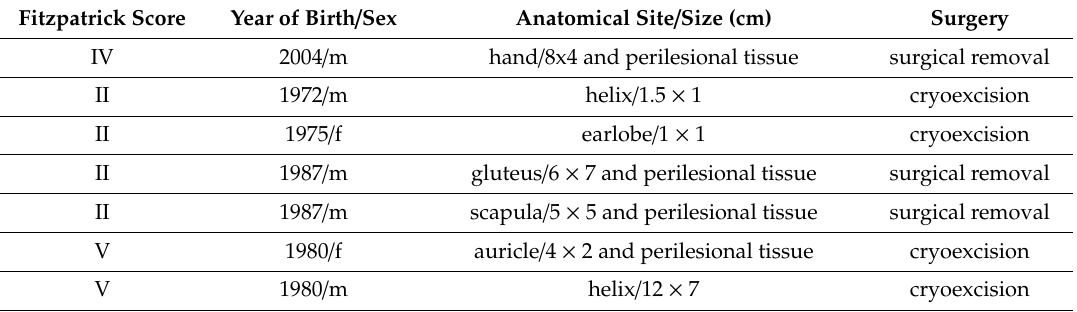
Figure 1. Example of human keloid tissue. Table 2. Characteristics of keloid and perilesional tissue used to prepare primary cultures of human fibroblasts.